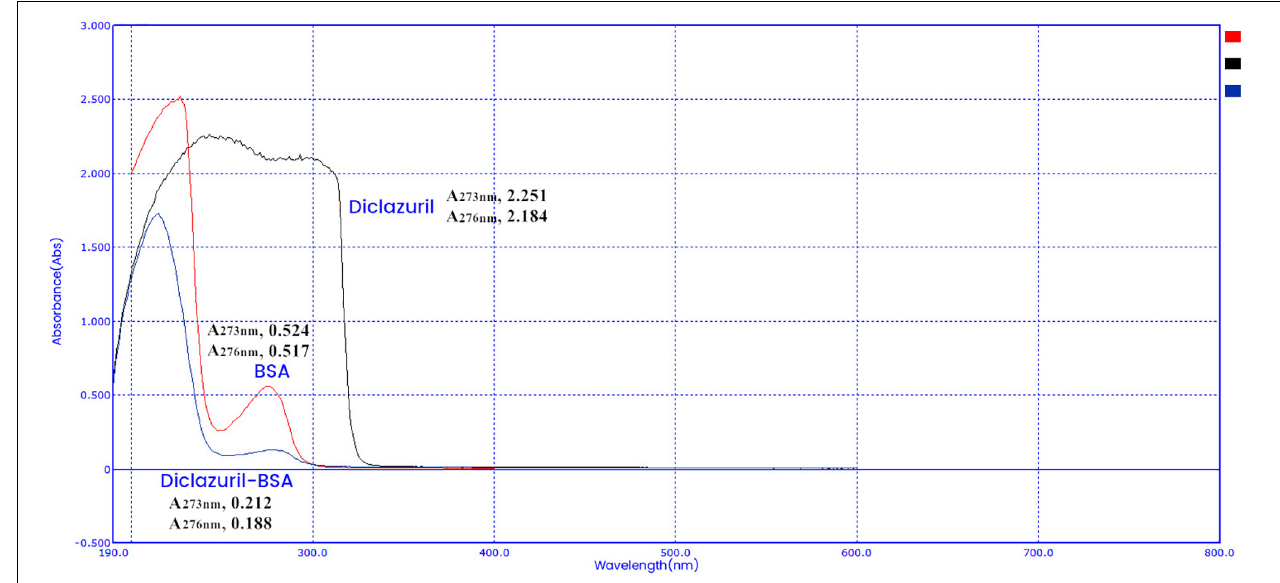
FIGURE 2 | UV scanning spectroscopy of the diclazuril-bovine serum albumin (BSA) conjugate.